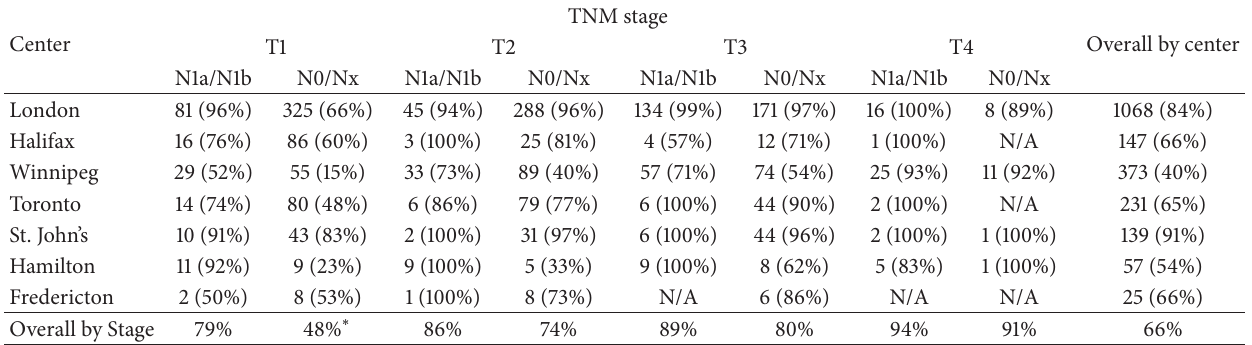
Table 6: Total Number of Patients by stage and per center receiving